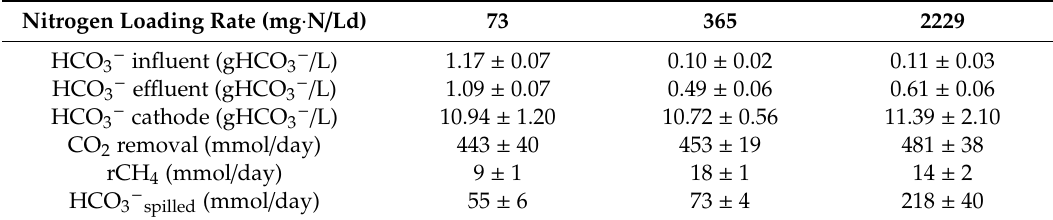
Table 3. Bicarbonate concentration in the different MEC liquid phases and the inorganic mass balance of the three different operating periods .